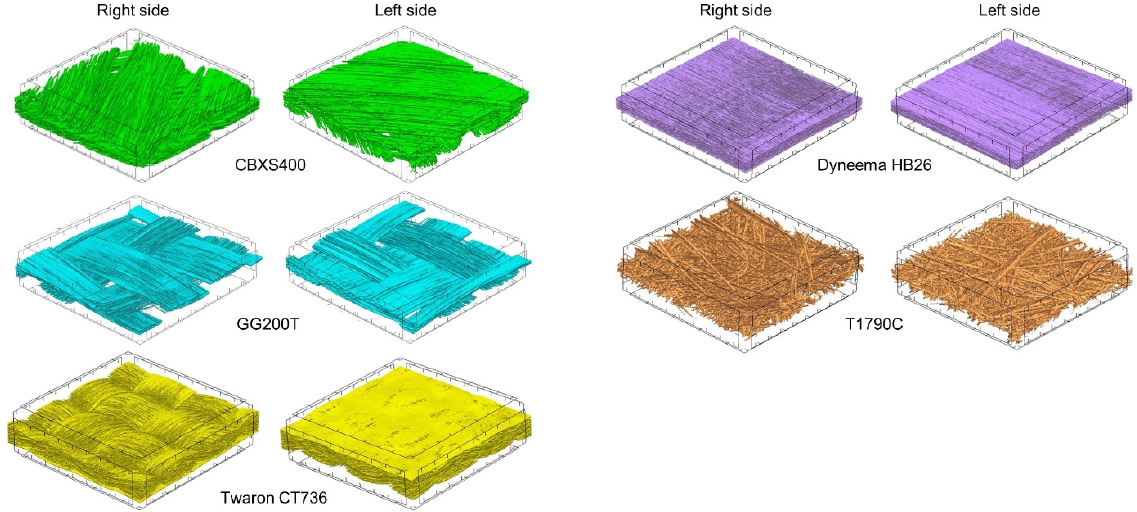
Figure 2. Micro-computed tomography 3D reconstructions of both sides of tested textiles (surface area: 4 mm × 4 mm).